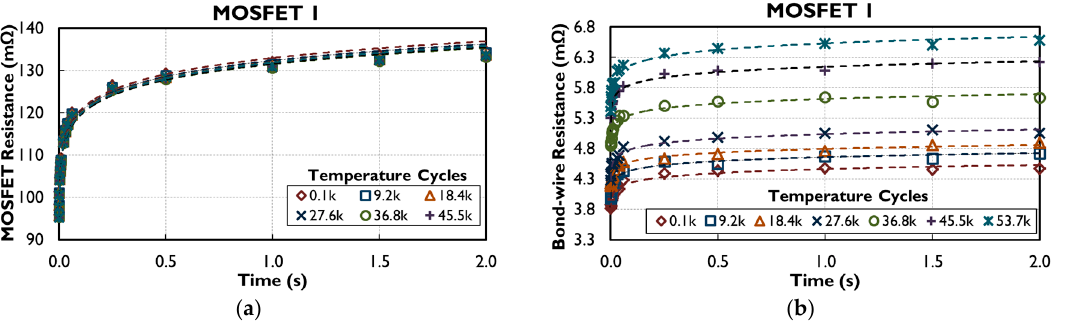
Figure 6. ( a ) MOSFET resistance throughout the 2 s current pulse, after increasing numbers of temperature cycles throughout the power cycling test; ( b ) Bond-wire resistance throughout the 2 s current pulse, after increasing numbers of temperature cycles throughout the power cycling test.